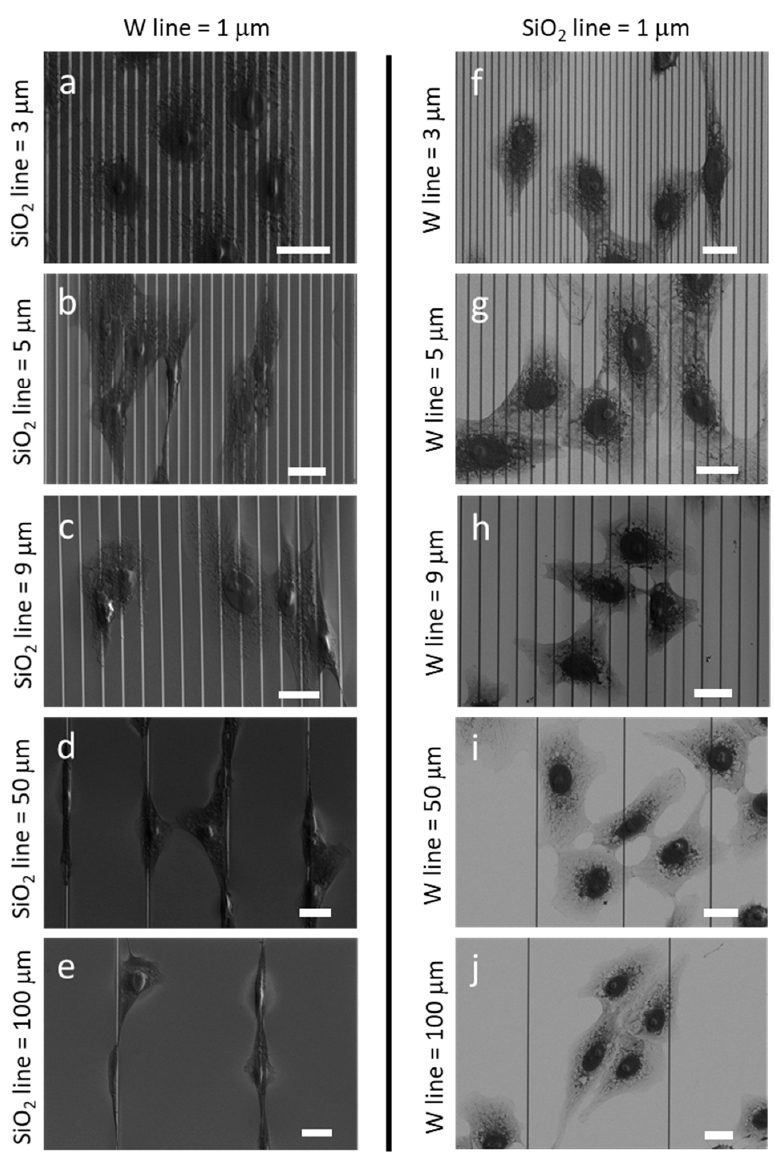
Figure 2. SEM micrograph of adherent cells on comb structures with different combinations of tungsten and silicon oxide line widths. ( a – e ) show substrates with a fixed tungsten line width of 1 µm and silicon oxide line widths of ( a ) 3 µm, ( b ) 5 µm, ( c ) 9 µm, ( d ) 50 µm, and ( e ) 100 µm. Additional substrates consist of fixed 1 µm silicon oxide lines and tungsten lines with widths of ( f ) 3 µm, ( g ) 5 µm, ( h ) 9 µm, ( i ) 50 µm, and ( j ) 100 µm. Scale bars represent 20 µm.